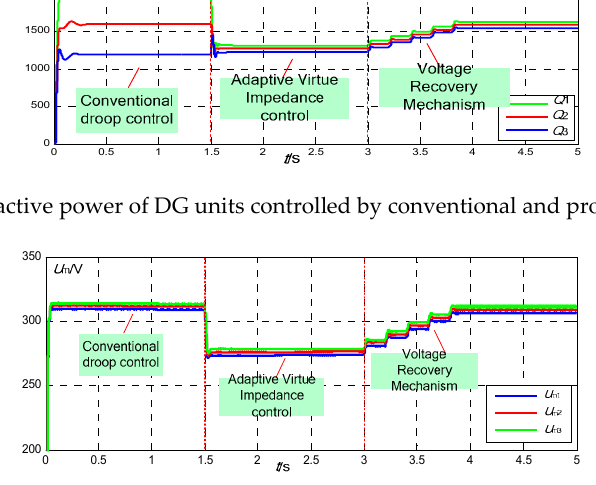
Figure 6. Simulation results of Test 1.